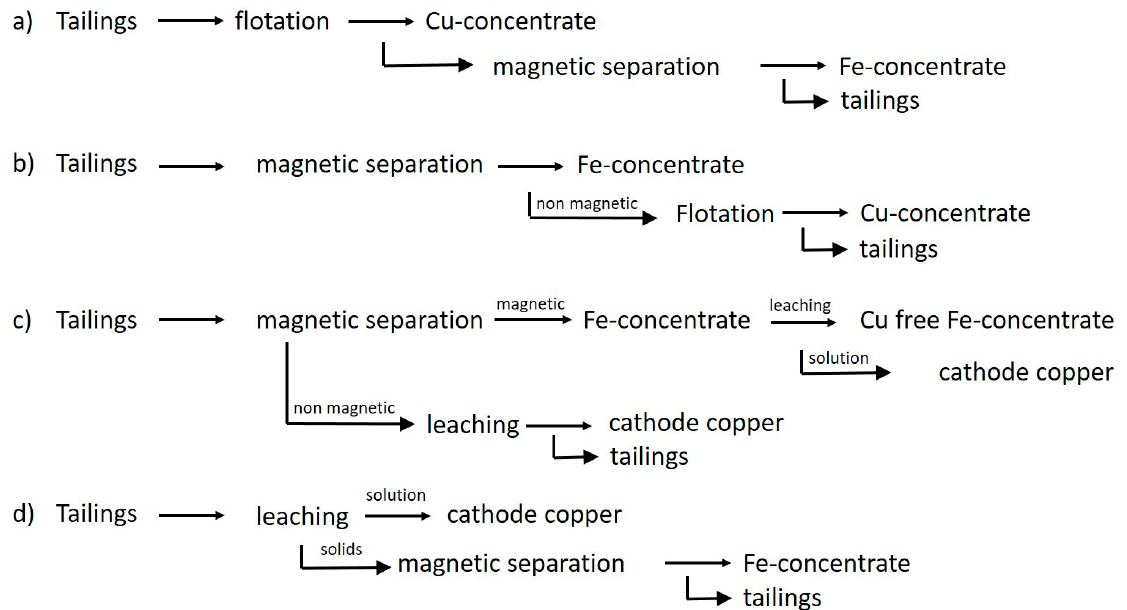
Figure 5. Different processing schemes ( a – d ) that were tested for the tailings of Taltal. The schemes ( a ) and ( b ) use flotation in combination with magnetic separation. Schemes ( c ) and ( d ) include leaching and magnetic separation. Table 4. Results of the performed flotation tests for copper oxides and sulfides. For Test 1, 1 kg